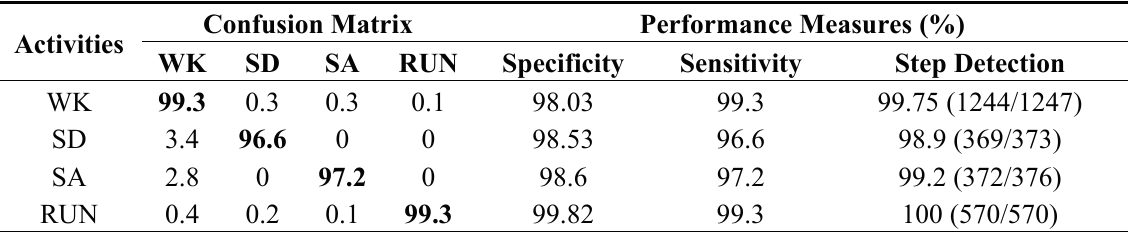
Table 3. Activity performance evaluation over raw